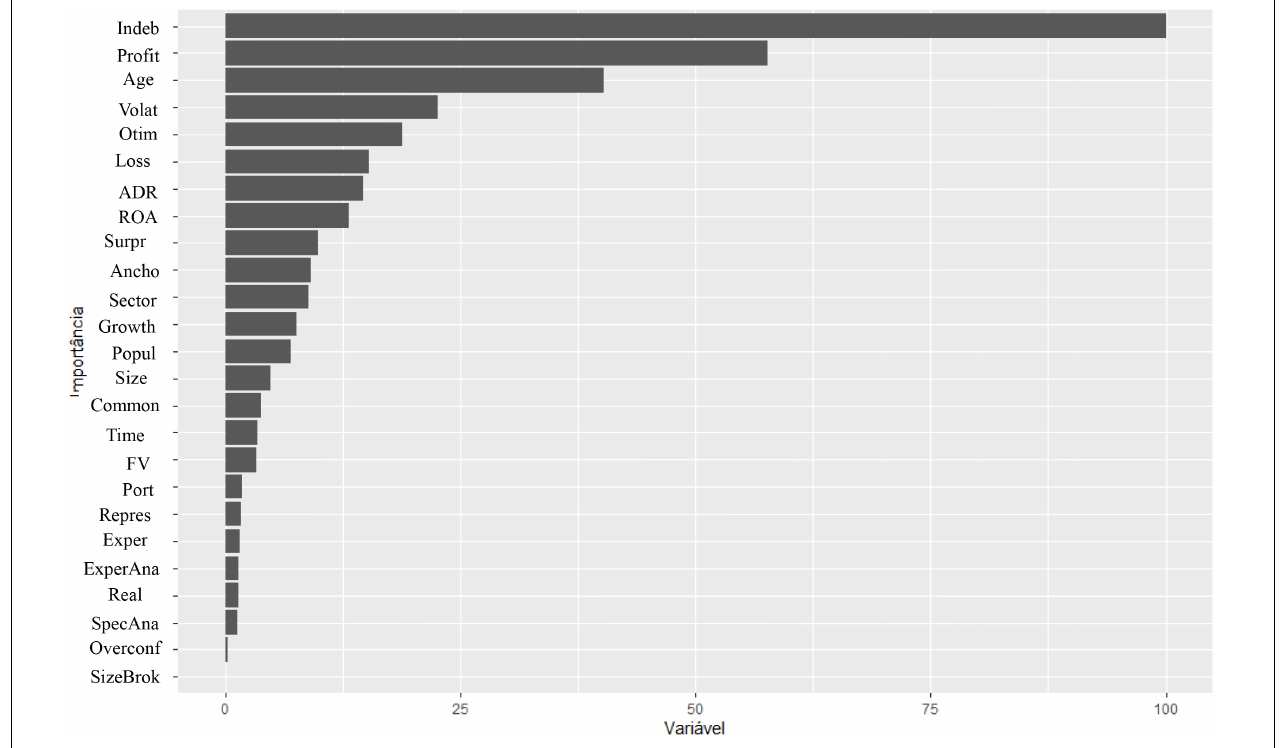
classification model by Bayesian networks allows us to verify which are the closest neighbor variables that alter a variable. We highlight some groups in this regard, such as the interrelationship between ADR, Loss, and FV, a point that shows that the anchor used by the analyzer has an influence of its optimistic bias